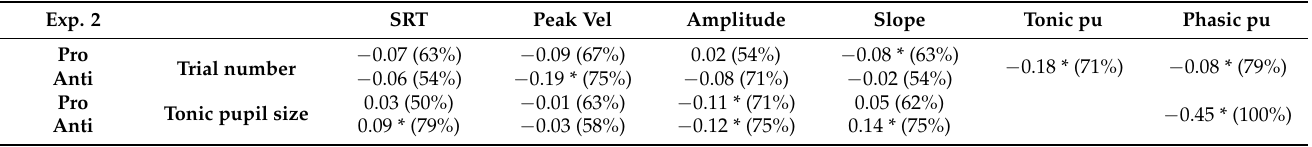
Table 2. Summary for the mean correlation coefficient values for each correlational analysis in Experiment 2 ( n = 24). * indicates statistically significant. Numbers in brackets indicate the per- centage of participants showing the same sign of correlation. SRT: saccade reaction time. Peak Vel: saccade peak velocity. Amplitude: saccade amplitude. Slope: the main sequence slope (peak veloc- ity/amplitude). Tonic pu: tonic pupil size. Phasic pu: phasic pupil dilation. Pro: pro-saccade